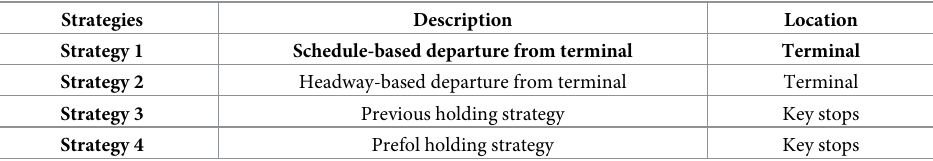
Table 1. Description of